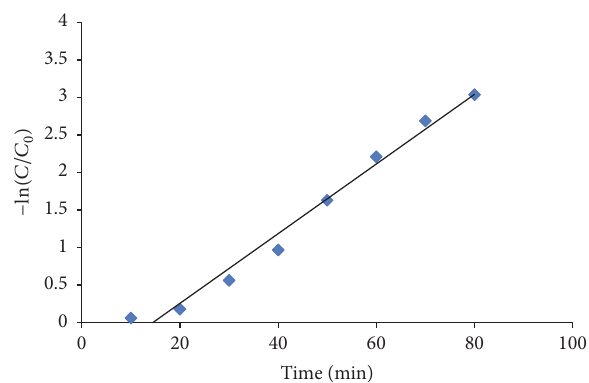
Figure 10: Pseudo-first-order plot for the photocatalytic degra- dation of furfural; TiO 2 /GAC composite dosage = 2.5 g/L, initial furfural concentration = 500 mg/L, and initial pH =